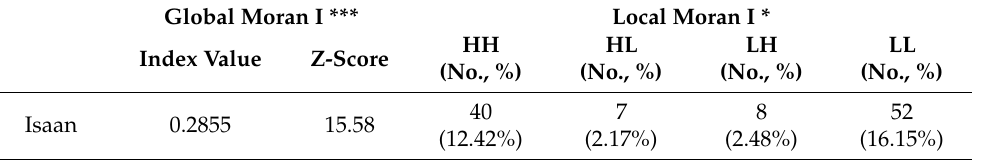
Table 3. Global Moran I and local Moran I